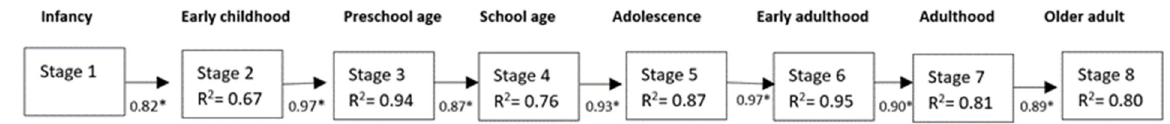
Figure 1. Path analysis model of Erickson’s theory of eight stages with direct and indirect effects (one-way sequential model and no stage could be omitted). Note: stage 1: trust versus mistrust, stage 2: autonomy versus shame, stage 3: initiative versus guilt, stage 4: industry versus inferiority, stage 5: identity versus role confusion, stage 6: intimacy versus isolation, stage 7: generativity versus stagnation, stage 8: integrity versus despair. p < 0.05 = *.